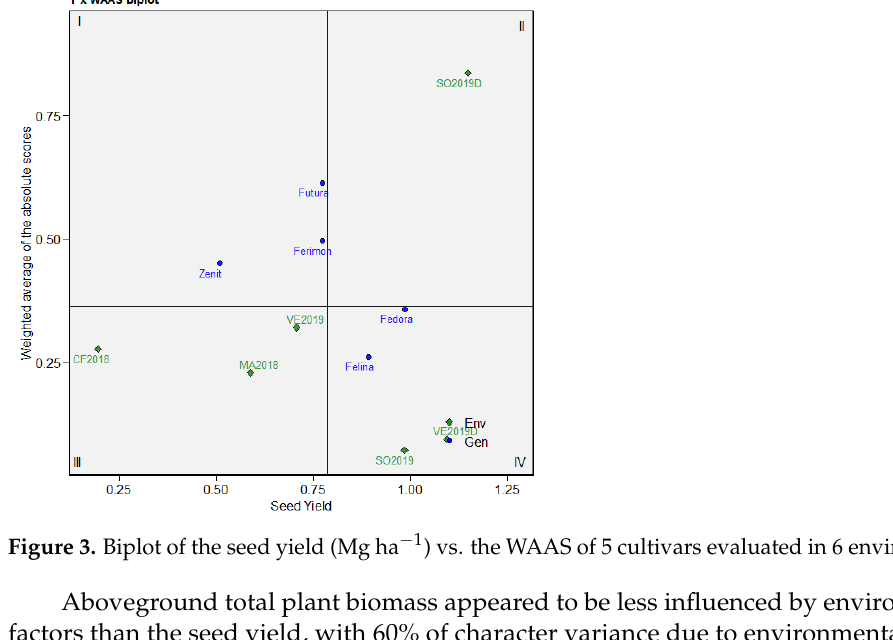
Figure 3. Biplot of the seed yield (Mg ha −1 ) vs. the WAAS of 5 cultivars evaluated in 6 environ- ments.